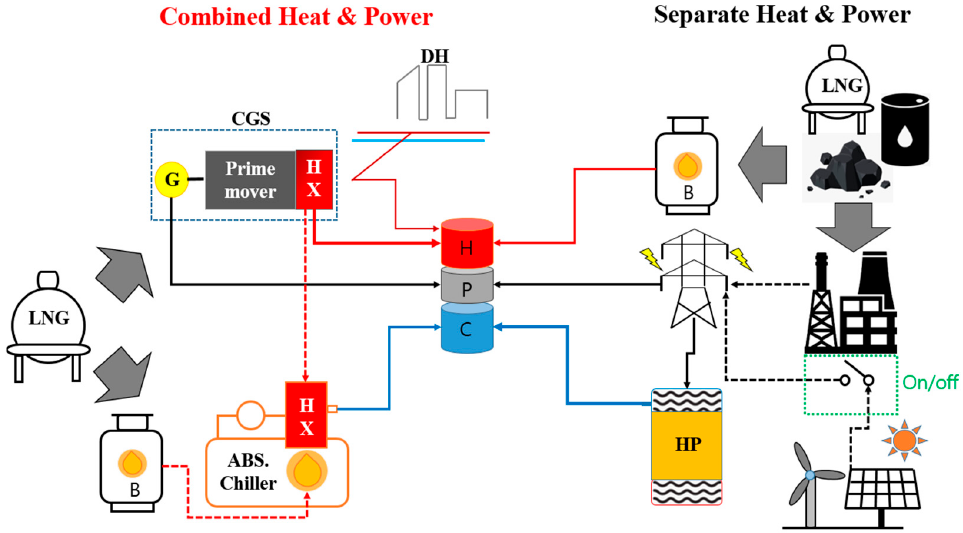
Figure 15. Illustrative diagram of the procedure for evaluating RPES of TGS.